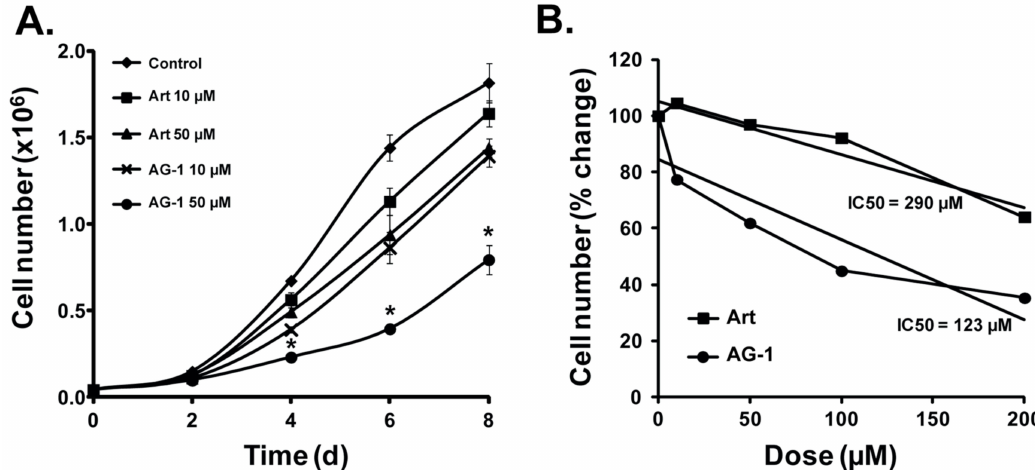
Figure 2. Artemisinin dimer (AG-1) treatment inhibits proliferation of MB-231 human mammary epithelial cancer cells. ( A ) Artemisinin (Art) dimer (AG-1) is more cytotoxic compared to